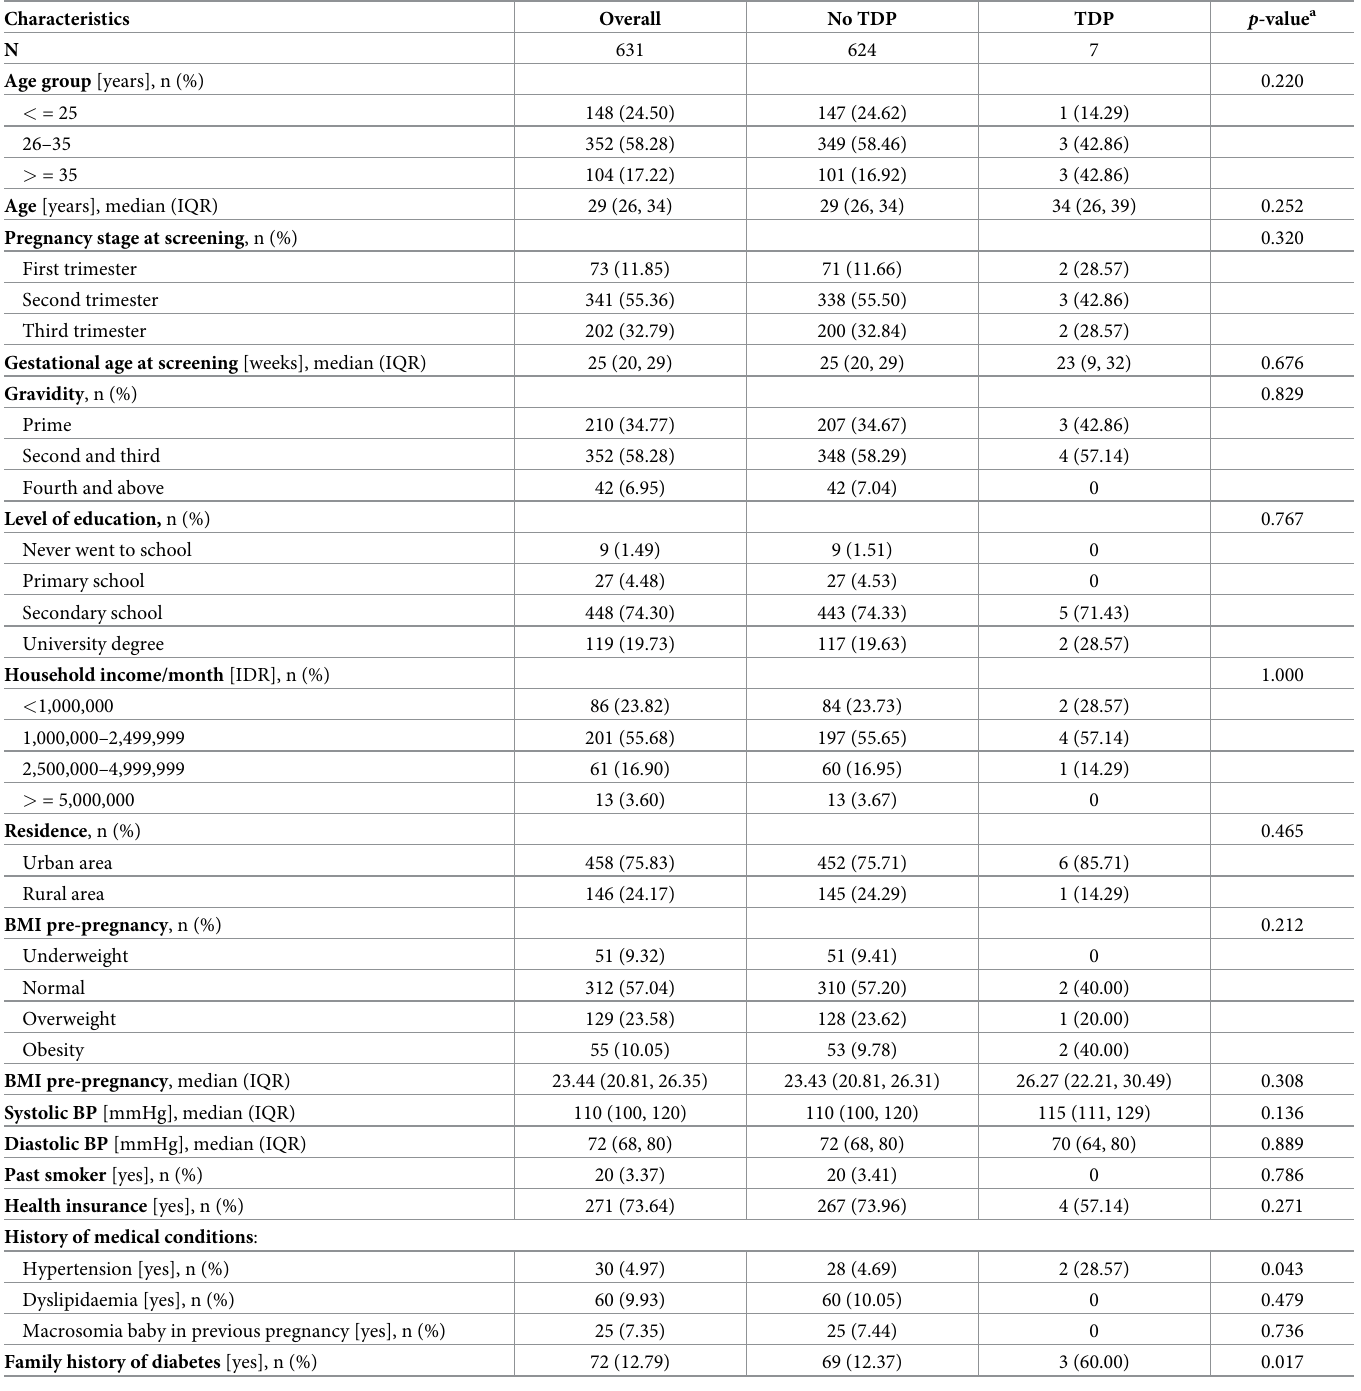
Table 1. Demographic characteristics of study participants with and without total diabetes in pregnancy.